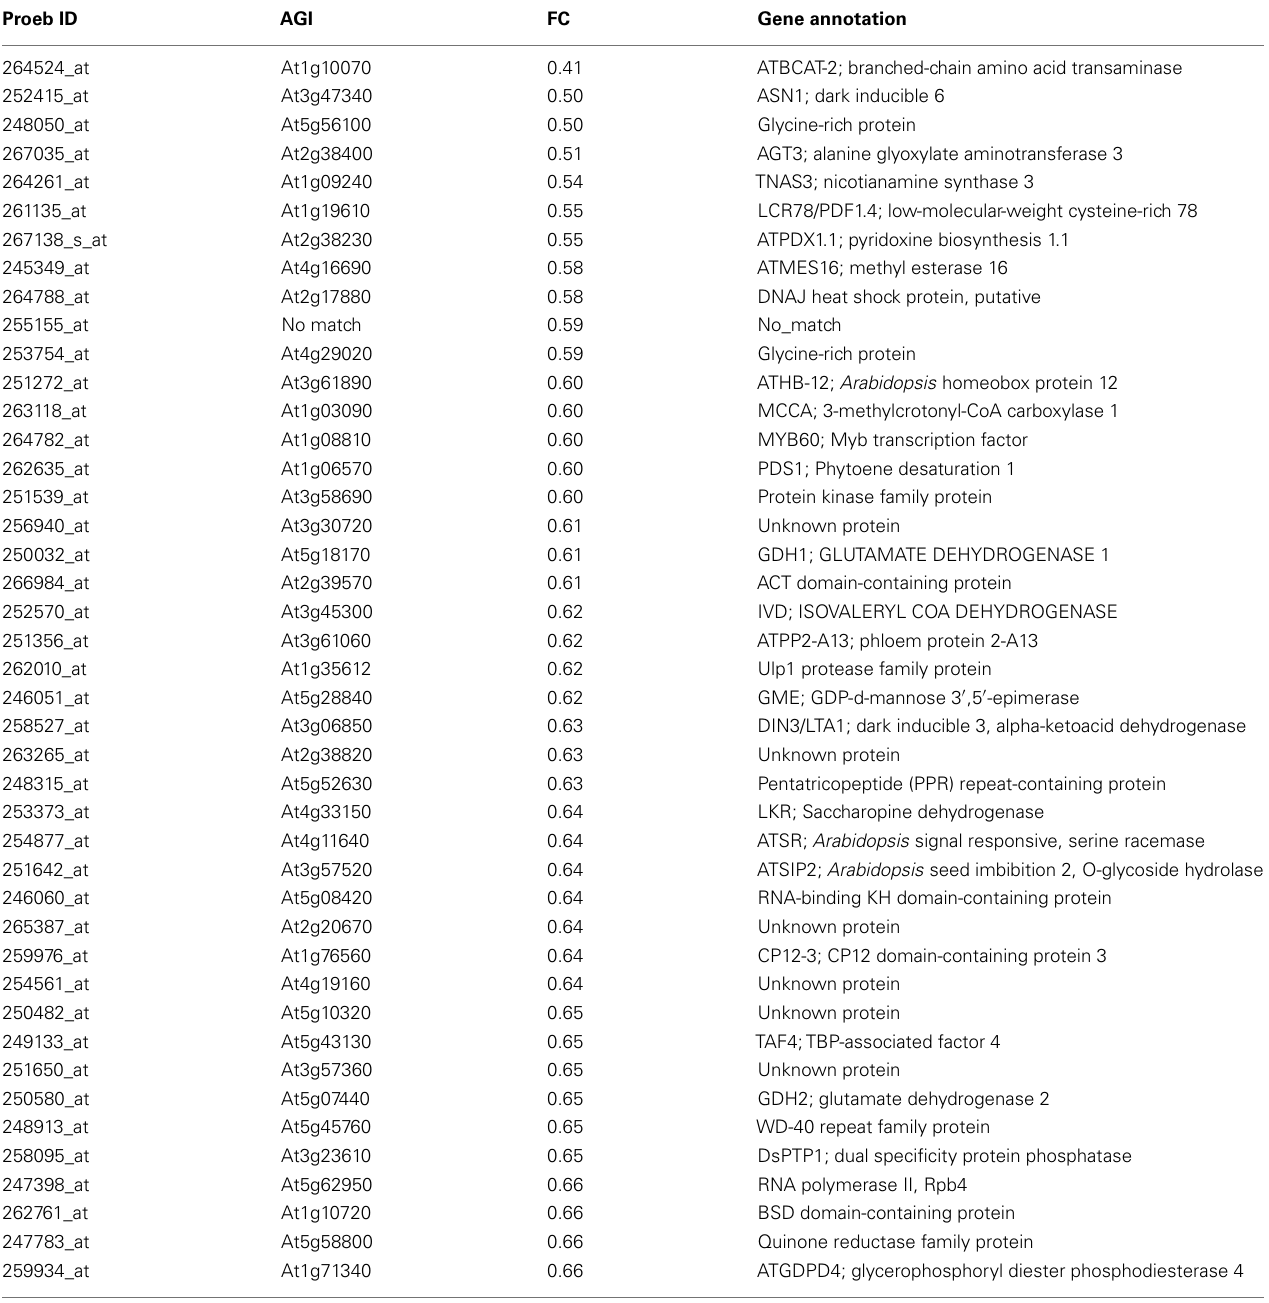
TableA4 | Expression values of down regulated of genes between control and SP-treated samples*. Proeb